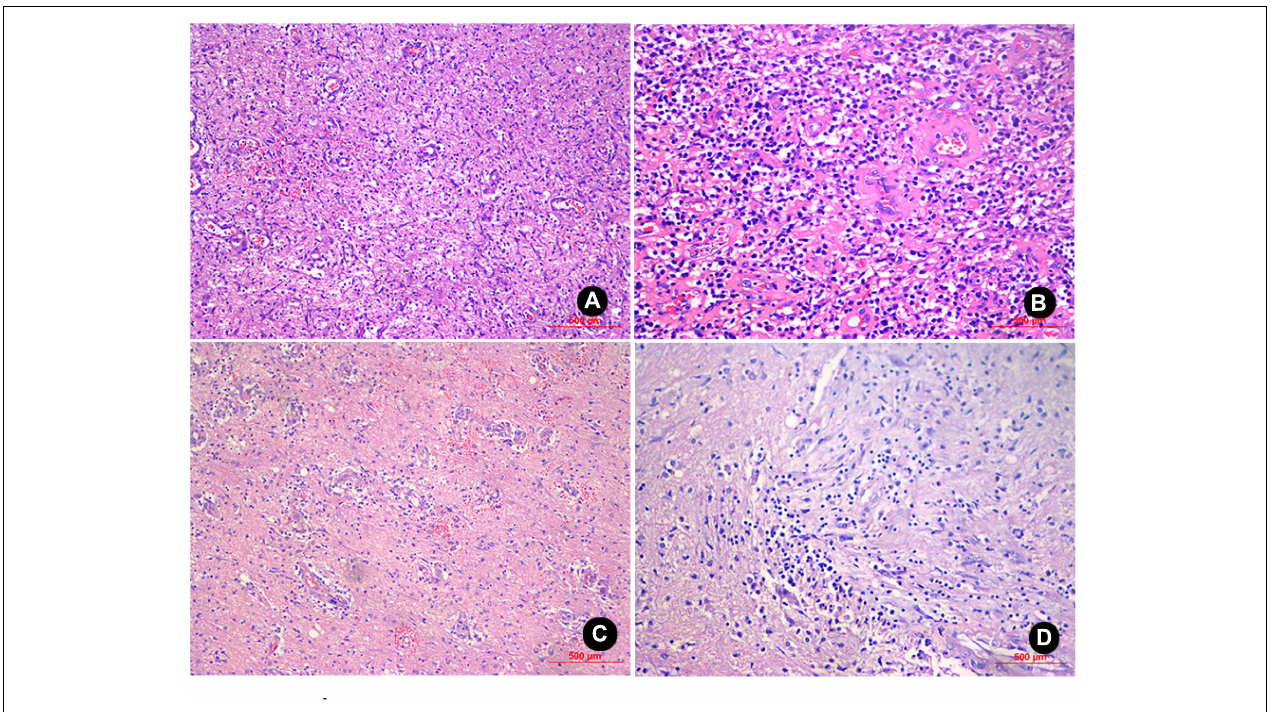
FIGURE 3 | H&E staining of the sample from patient No. 1 (100X and 200X magnification) revealed inflammatory exudates, necrosis, and granulations in the glial cells, and local foci contained mucoid degeneration and micro-abscesses (A,B) . H&E staining of the sample from patient No. 2 (100X and 200X magnification) revealed the presence of inflammatory exudates, necrosis, and abscess; the glial cells contained a high level of lymphocyte infiltration and angiogenesis (C,D)